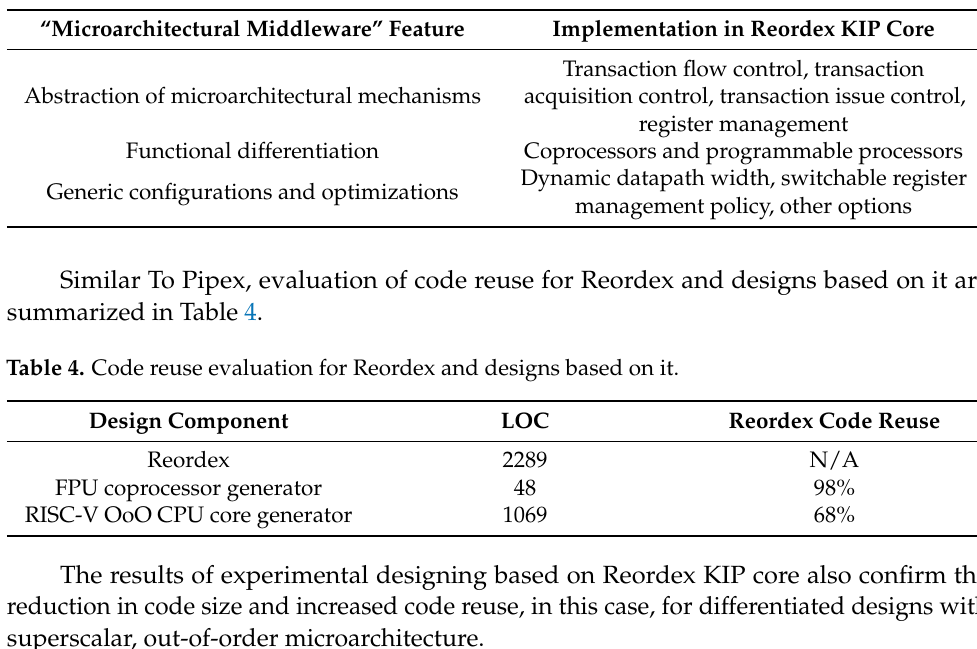
Table 4. Code reuse evaluation for Reordex and designs based on it.